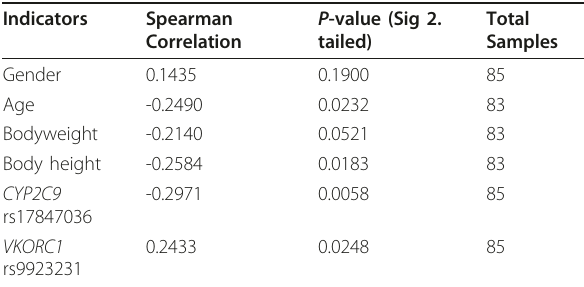
Table 3 Spearman correlation of warfarin dose based on different indicators